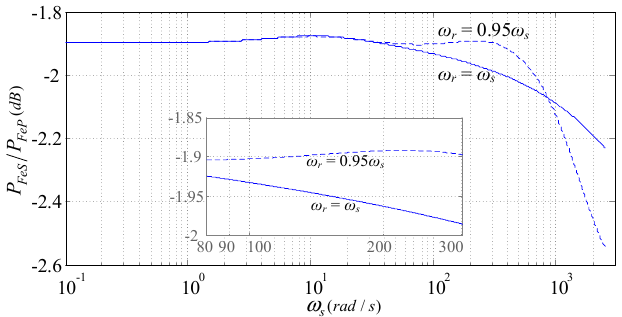
Figure 4. Iron-loss (ILS) ratio function of series model and parallel model.